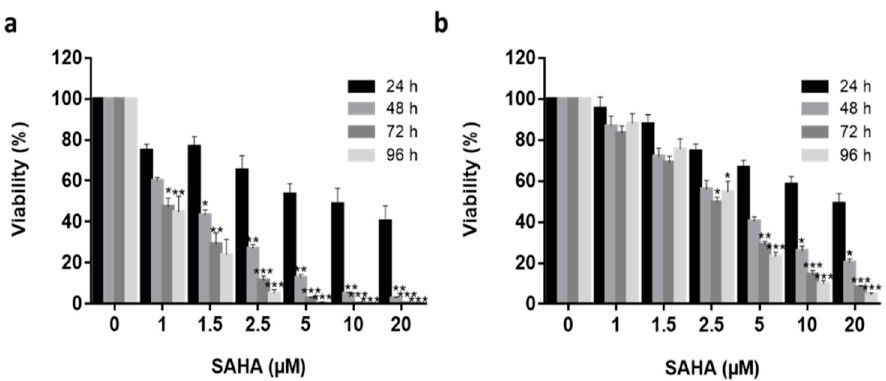
Figure 1. Free SAHA drug cytotoxicity in in vitro Endometrial cancer models. Increasing concentra-